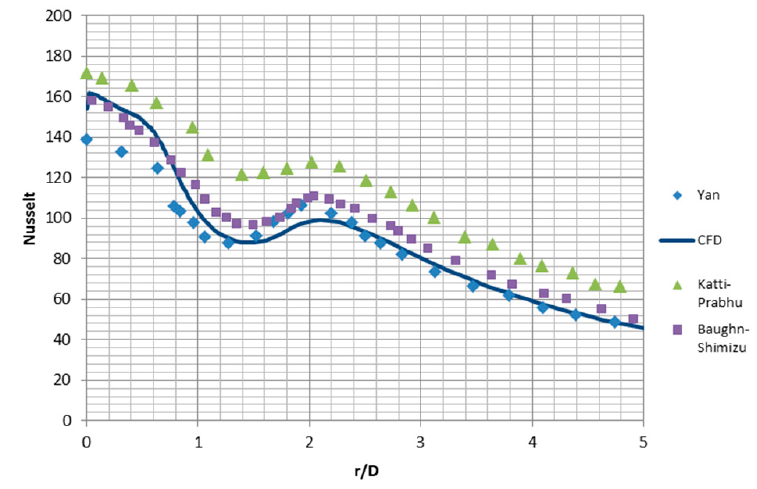
Figure 3. Nusselt number along the wall H/D = 2—CFD vs. experimental data.